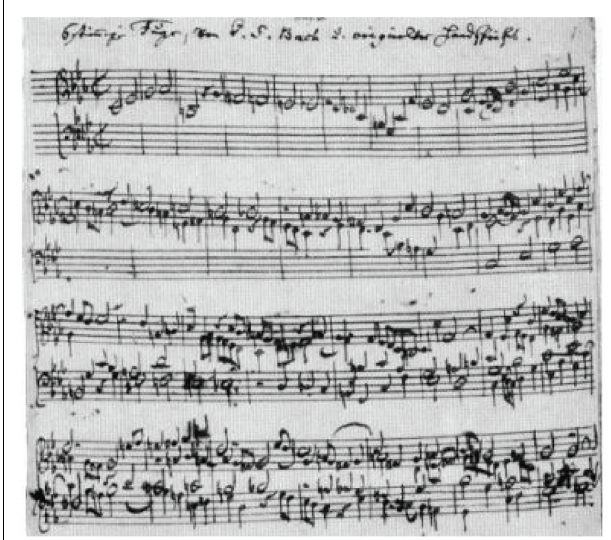
FIGURE 6 |The musical offering, J. S. Bach (ca 1747). Ricercar, a 6. In this score in Bach’s handwriting, the RoyalTheme that was “offered” to Bach by Frederick II of Prussia can be seen at the top of the page. It is a monodic melody, with a single voice. After a few bars, however, additional melodic lines can be seen to appear.Voice-leading becomes increasingly intricate as the music progresses (see also Sound Examples S3 and S4 in Supplementary